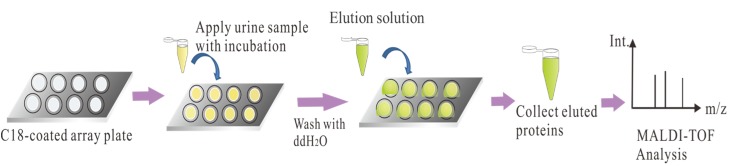
Analytical flowchart of urinary proteins by C18 plate-MALDI-TOF approach.Urine samples were from healthy, DM-WNP, DM-NP or WDM-NP subjects.